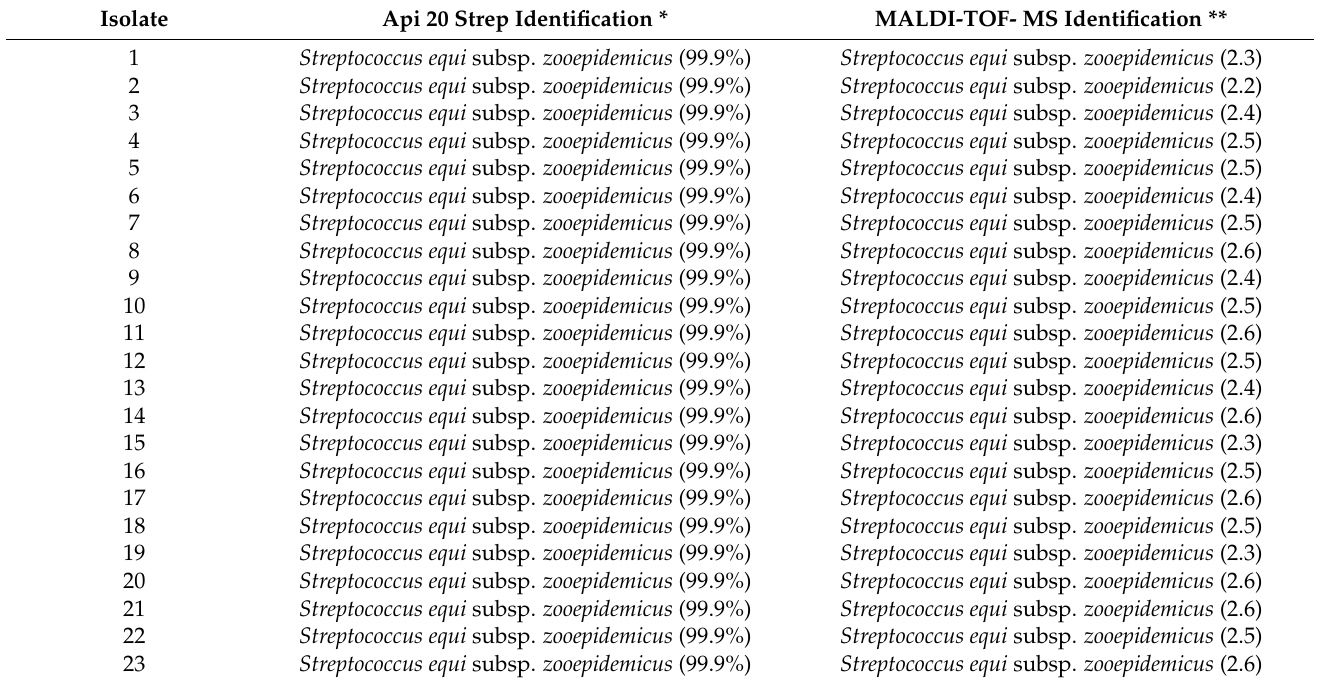
Table 1. Api 20 Strep and MALDI-TOF-MS S. zooepidemicus identification